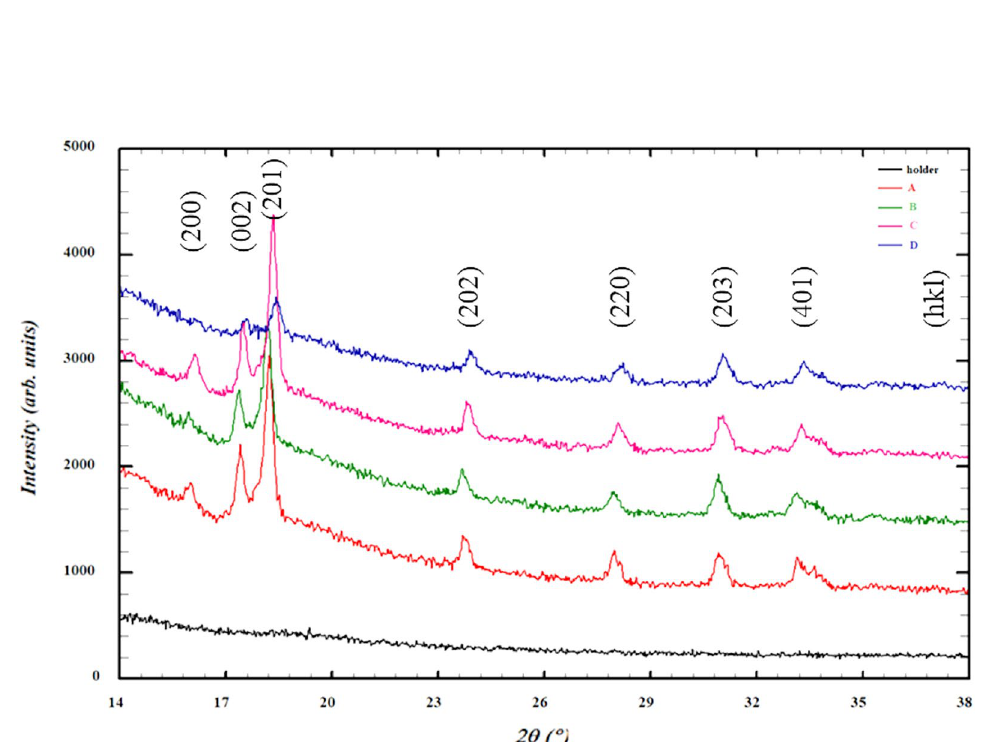
Figure 4. X-ray diffractograms of the sintered Ti6Al4V alloy composites with and without biogenic filler. Series: A—0%, B—1%, C—5%,